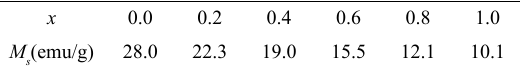
Table 2. The saturation magnetization ( M garnet samples.